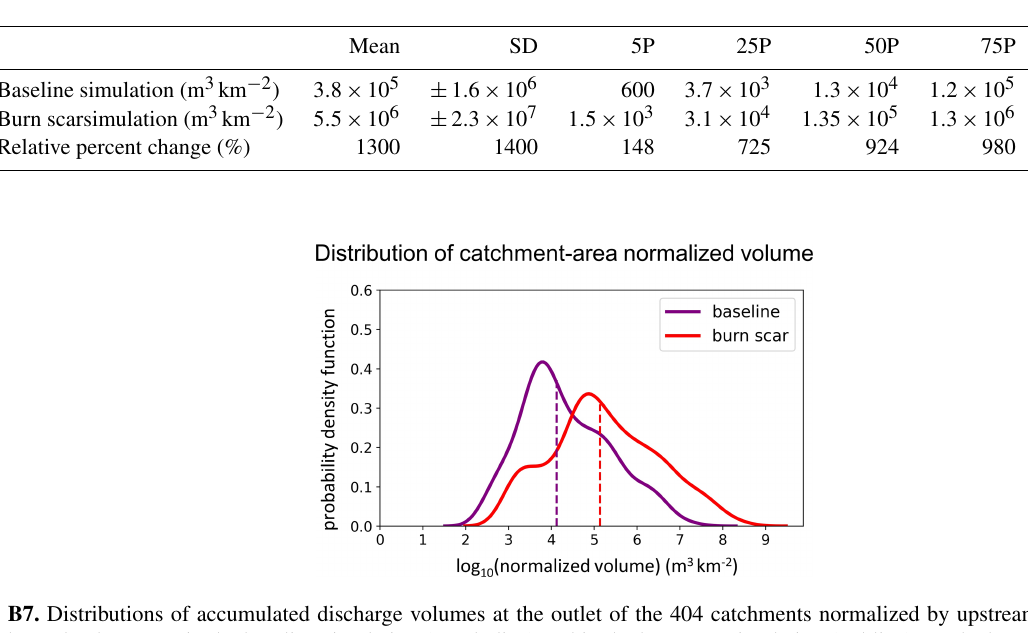
Table B5. Statistics, including the mean, standard deviation (SD), 5P, 25P, 50P, 75P, and 95P, of the catchment-area-normalized discharge volume for all the 404 basins within the Dolan burn scar in the baseline and burn scar simulation and their relative percent changes.